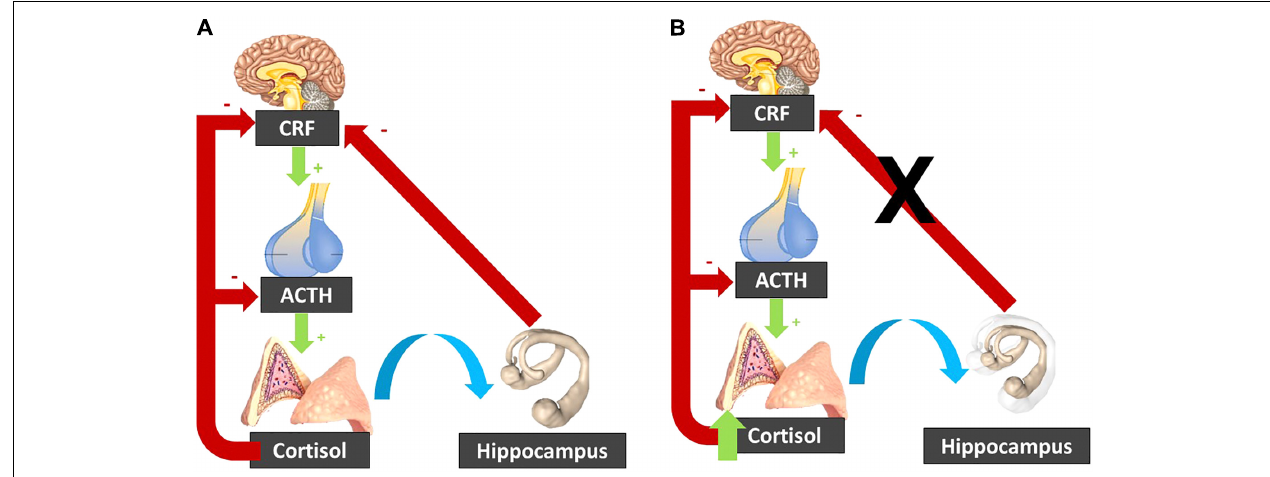
FIGURE 3 | (A) In normal circumstances, the CRF released by the hypothalamus activates ACTH release by the pituitary gland, which stimulates the adrenal glands to secrete cortisol. Cortisol inhibits its own secretion via a negative feedback loop. The hippocampus inhibits the hypothalamo-pituitary-adrenal axis. (B) When cortisol is elevated, it can induce hippocampal atrophy, which “lifts the brake” on the hypothalamo-pituitary-adrenal axis. The resulting cortisol increase induces further hippocampal atrophy, resulting in a vicious circle. CRF, corticotropin-releasing factor; ACTH, Adrenocorticotropic